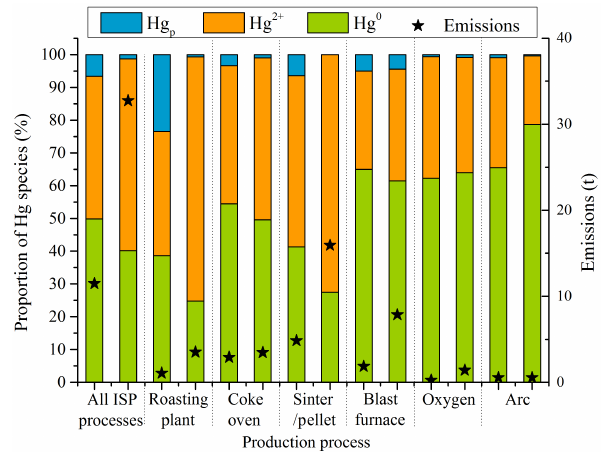
Figure 4. Proportion of different Hg species (f1or each process, the left and right column represent the data in 2000 and 2015, respec-